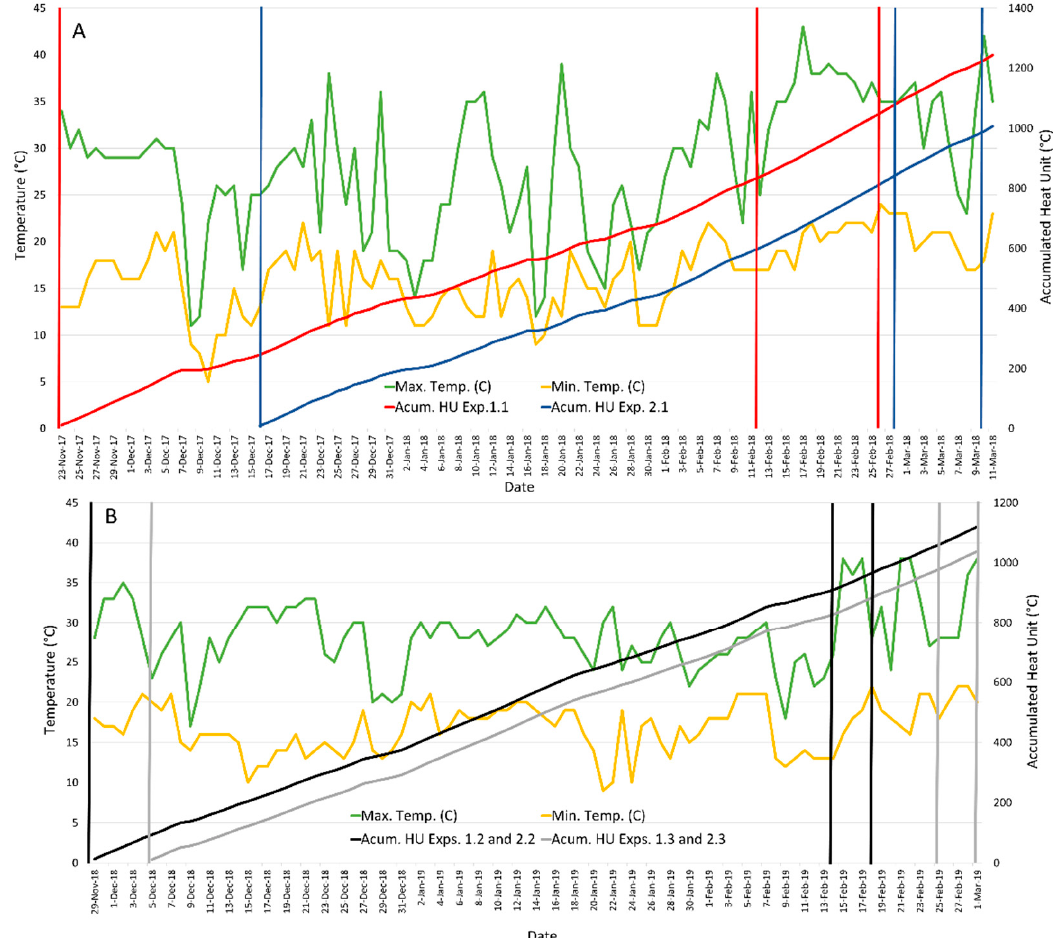
Figure 1. Maximum and minimum temperatures and accumulated Heat Units (HU) at the International Maize and Wheat Improvement Center (CIMMYT) Tropical Experimental Station. Vertical lines indicate sowing dates and flowering periods: ( A ): Red, Exp. 1.1; blue, Exp. 2.1; ( B ): Black, Exps. 1.2 and 2.2; gray, Exps. 1.3 and 2.3.